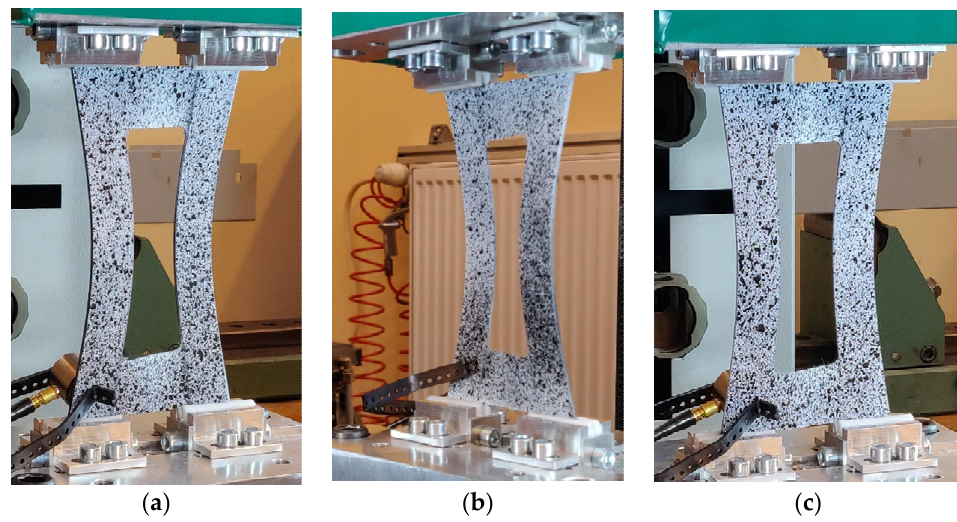
Figure 9. Experimental results for plate with angles ( a ) 30°, ( b ) 45°, and ( c ) 60°.